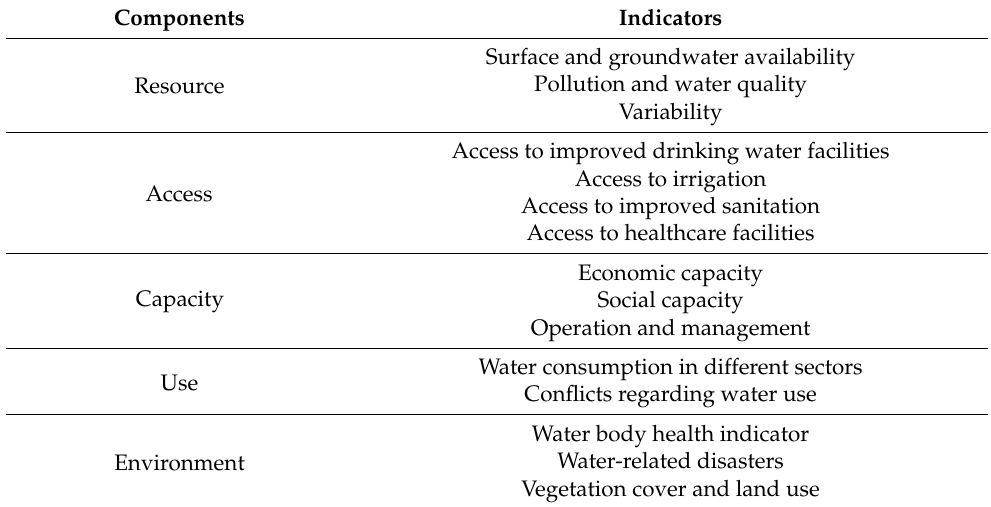
Table 1. WPI structure used in the